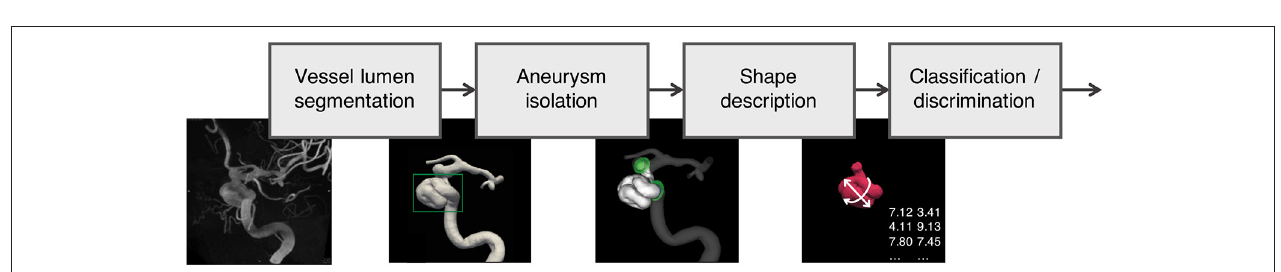
FIGURE 2 | Data processing pipeline applied to all aneurysms in the AneuX morphology database: Using robust vessel lumen segmentation techniques, a geometric model of the aneurysm and the surrounding vasculature is extracted from the 3DRAs. Subsequently, the aneurysm is isolated by means of (planar or non-planar) cuts. For the resulting aneurysm models, morphometric features were computed, which were then analyzed and compared with additional clinical information about the cases (classification/discrimination). 3DRA, 3D rotational